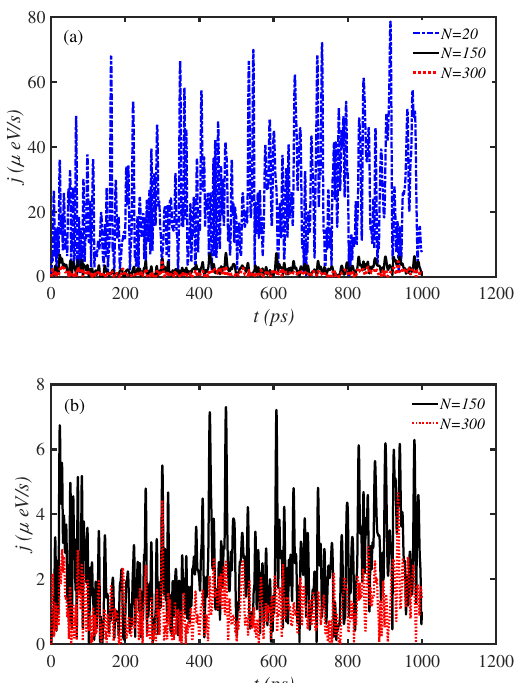
Figure 1. Time series of energy transport rate, j , along protein chains of different length. ( a ) The blue dashed line, the black solid line, and the red dotted line correspond to N = 20, N = 150, and N = 300 site amino acid chains, respectively. ( b ) The black solid line and the red dotted line correspond to N = 150 and N = 300 site amino acid chains,